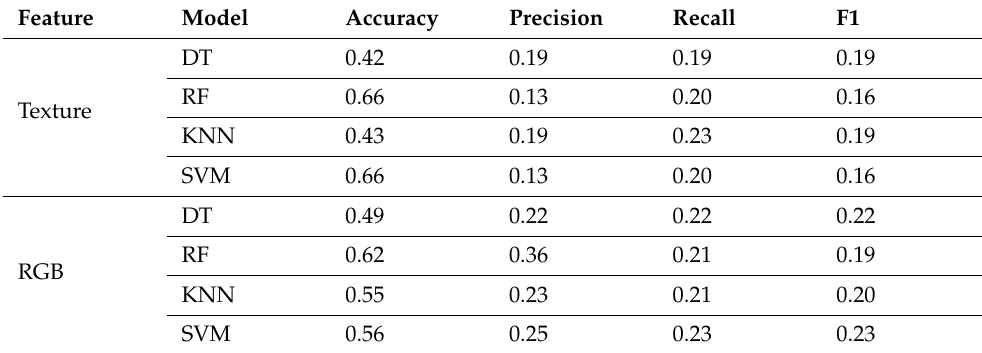
Table 8. Results of machine learning modes on the original dataset.